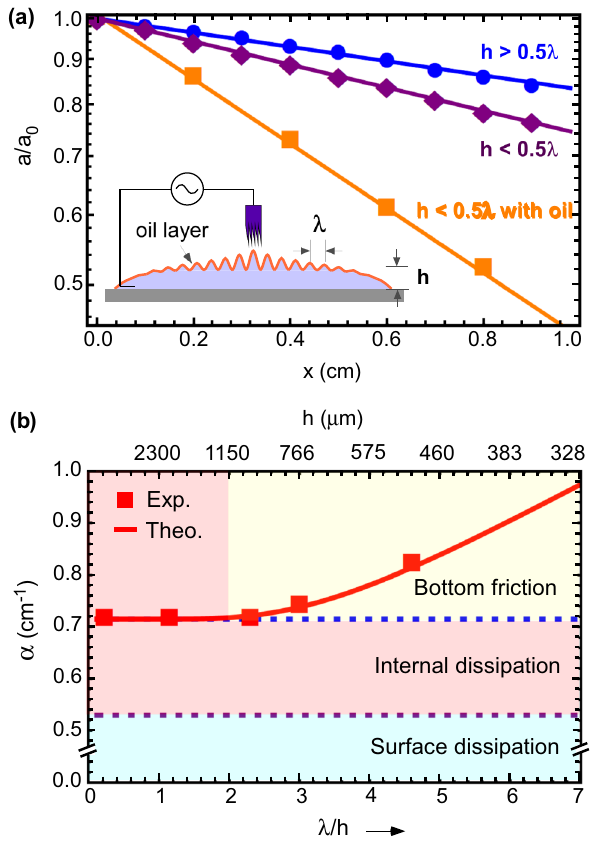
Figure 4. Manifestation of three processes of wave attenuation. ( a ) Exponential decay of wave amplitude in deep water h > 0.5 (cid:31) , shallow water h < 0.5 (cid:31) and shallow water covered with thin layer of mustard oil at 160 Hz frequency. Inset illustrates the studied geometry. ( b ) Measured and theoretical values of wave attenuation coefficient, α , is plotted with shaded region of different contributions of energy dissipation. Error bars are within the size of data points (red